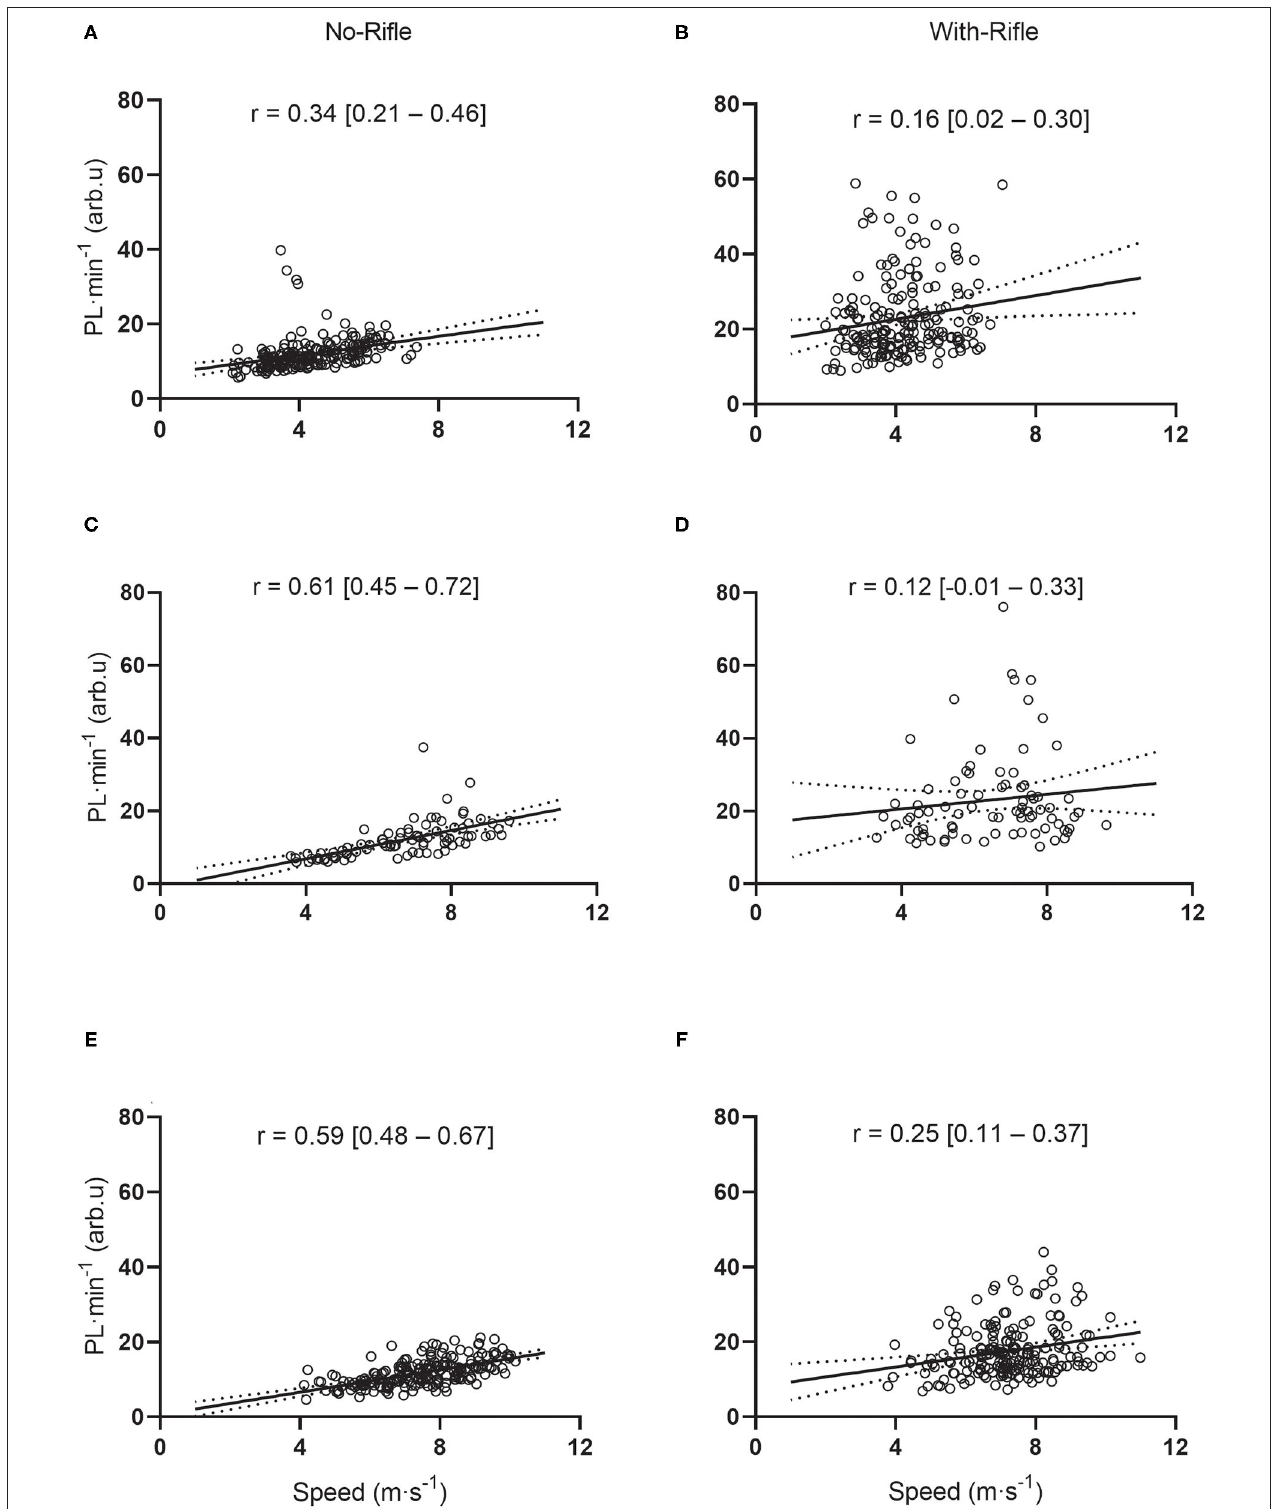
FIGURE 6 | Scatterplots displaying relationships between PlayerLoad TM per minute and skiing speed during Uphill, Flat and Downhill gradients with and without the biathlon rifle. Each dot represents an individual speed (x) vs. PlayerLoad TM per minute (y) (for the pelvis sensor) for every Uphill (A,B) , Flat (C,D) and Downhill (E,F) section. Panels on the left are for No-Rifle; Panels on the right are for With-Rifle. Pearson correlation coefficient ( r ) with 95% confidence interval shown.